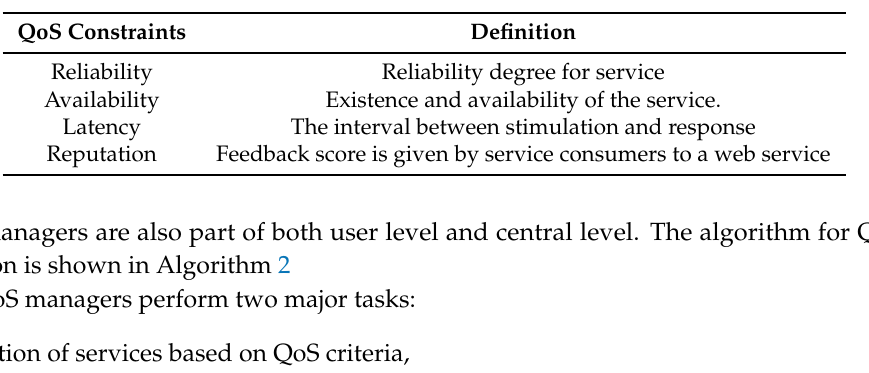
Table 1. Quality of service constraints